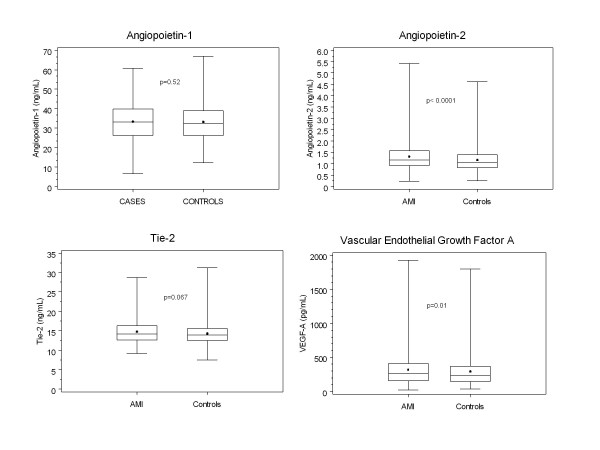
Box plots of Angiopoietin-1, Angiopoietin-2, Tie-2, and Vascular Endothelial Growth Factor-A, by Case-Control Status showing minimum, 25th, 50th (horizontal bar), mean (dot), 75th percentile and maximum.